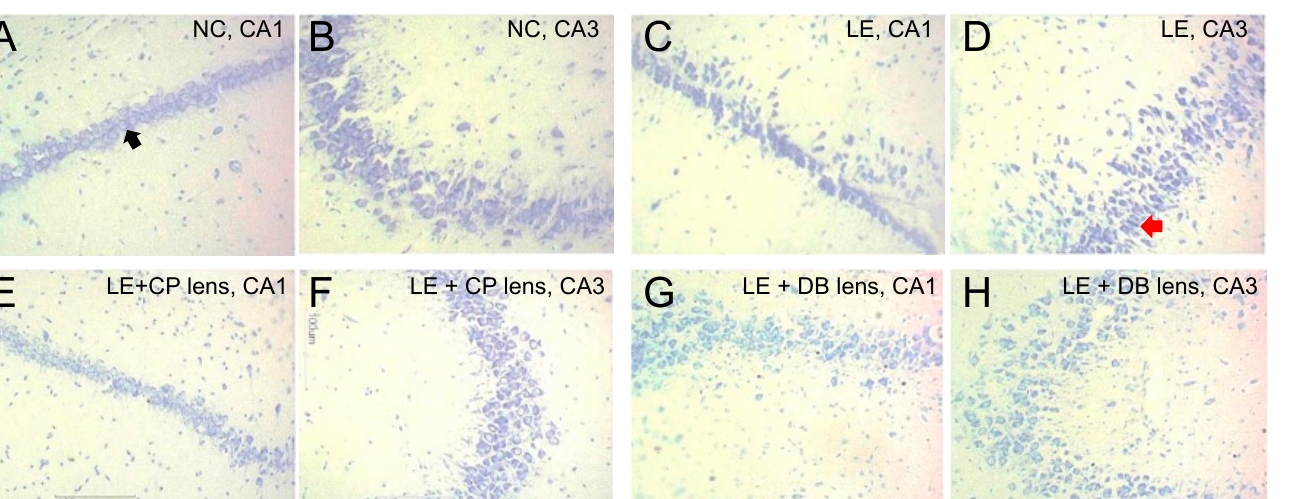
Figure 5. ( A ) Comparison of the healthy and degenerated CA1 and ( B ) CA3 neurons. Data for n = 6 animals from each group are shown as the mean ± SD for healthy and degenerated neurons. 4. Discussion This study found that 28 days following exposure to high levels of short-wavelength light, there was a deficit in spatial learning on day 1, which was ameliorated with blue- light-blocking lenses. This functional deficit was associated with changes to the complex- ity of hippocampal neurons, particularly the basal dendrites in neurons in CA1 and CA3 regions. There was also evidence of more cells with pyknotic nuclei, particularly in CA3. Consistent with better function (at day 1) with BBLs, the lenses ameliorated some of these structure deficits induced by exposure to high levels of short-wavelength light. In a previous study employing the same light exposure protocol, the retina was thinned and neurons in layer 5 of the visual cortex were negatively impacted, particularly with reductions in basal dendrites [31,45]. The current data show that similar changes were also present in the hippocampus. Previous studies showed that changing the diurnal cycle results in changes in hippocampal neurons. In comparison with a normal light to dark ratio (14 h at~150 lux and 10 h at 0 lux), Nile grass diurnal rats kept in dim light at